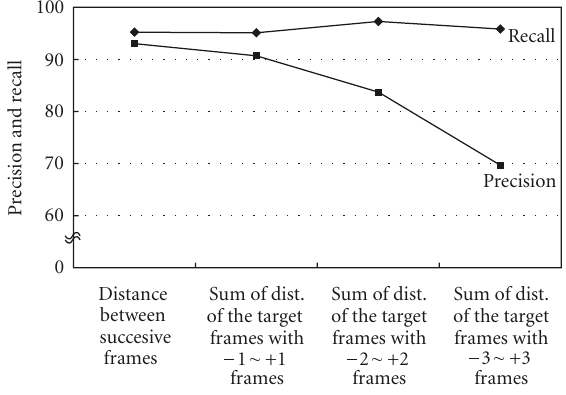
Figure 8: Precision and recall rates when the number of neighbor- ing frames involved in calculation of degree of motion was changed. Sequence #2-1 was used. Table 2: Performance summary of motion